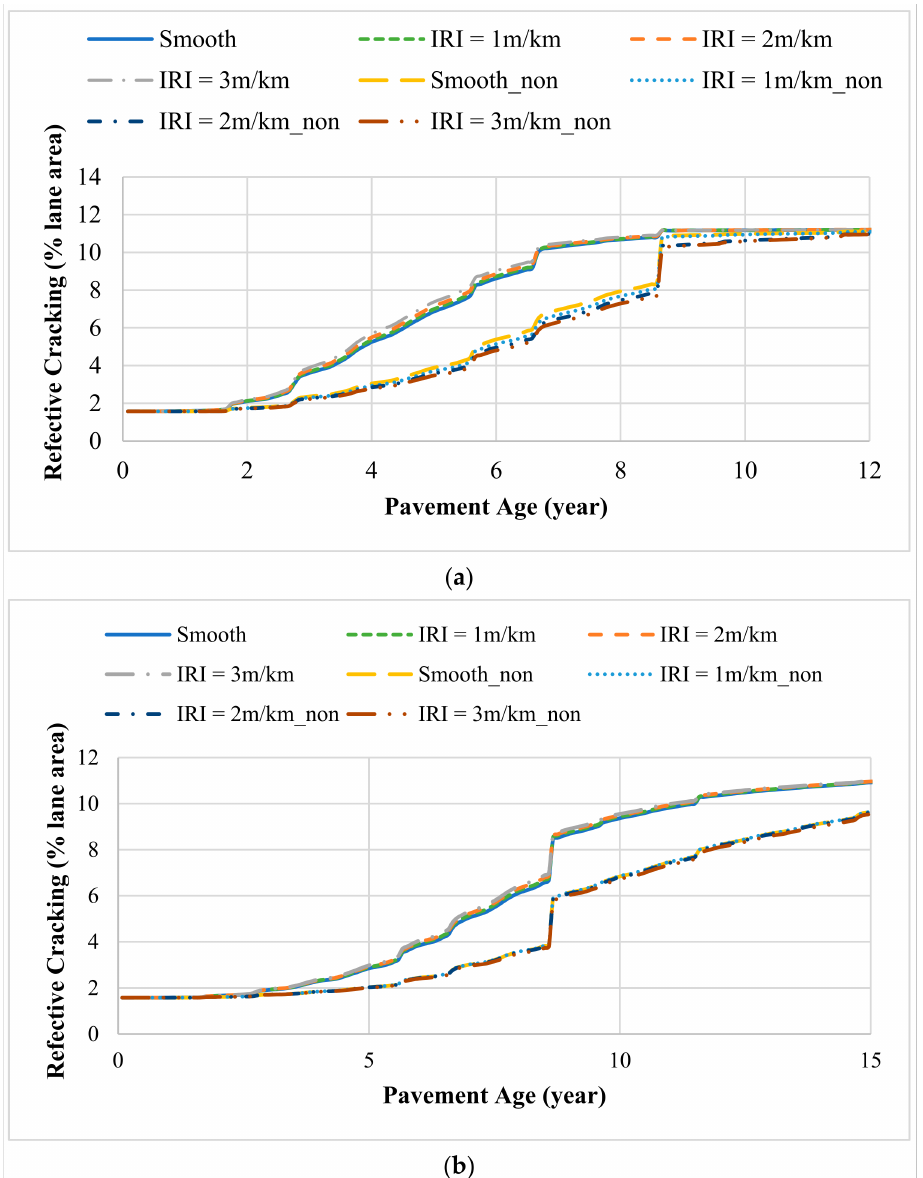
Figure 9. Fatigue cracking (reflective) of ( a ) major highway and ( b ) minor highway under total and non-overweight traffic (10% existing